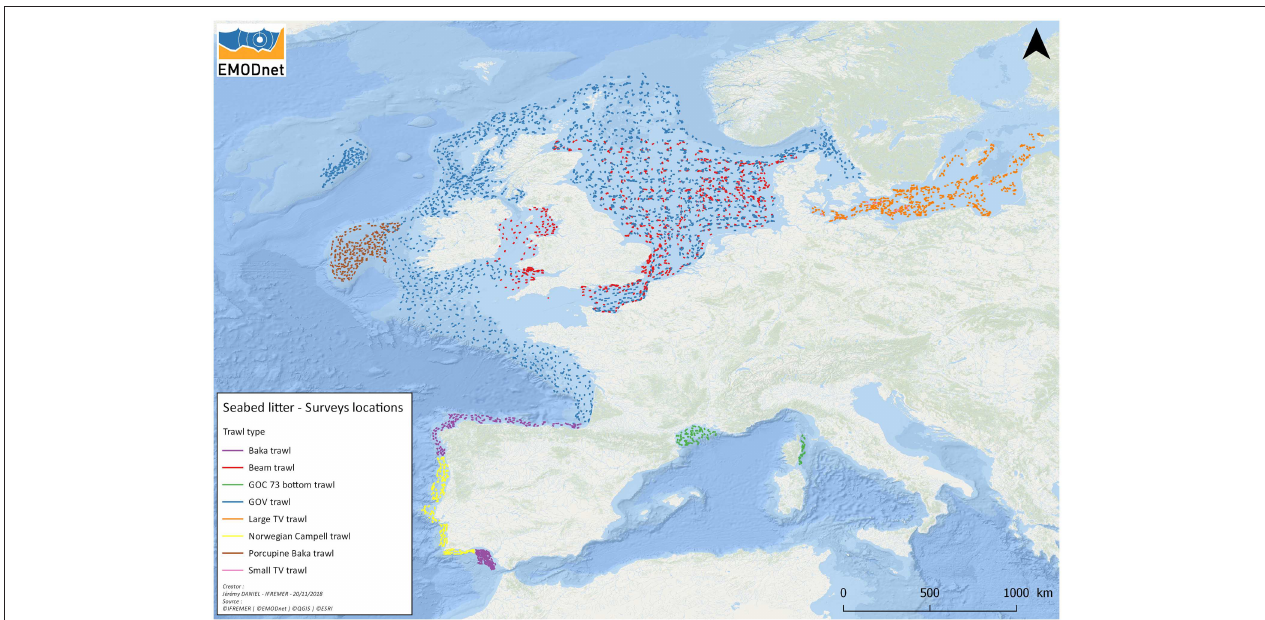
FIGURE 11 | Spatial distribution of seafloor litter survey transects and gear types used for sampling (the EMODnet Chemistry project, whose PIs are among the authors of this paper, holds the copyright on this figure).